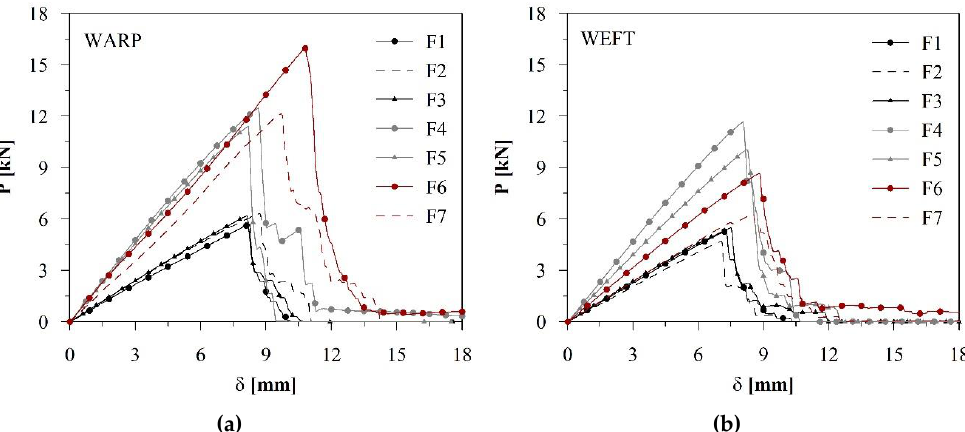
Figure 3. Fabric average tensile responses in terms of load vs. displacement: in the warp direction ( a ); and in the weft direction ( b ).